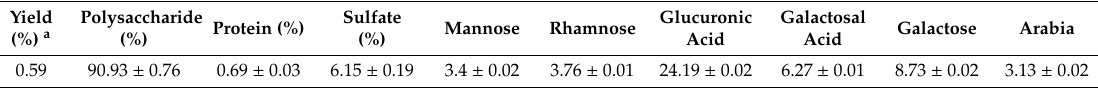
Table 1. Physicochemical characterization of okra (OP).